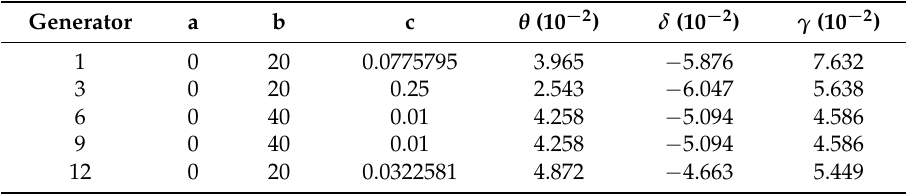
Table 4. Cost and emission coefficients of